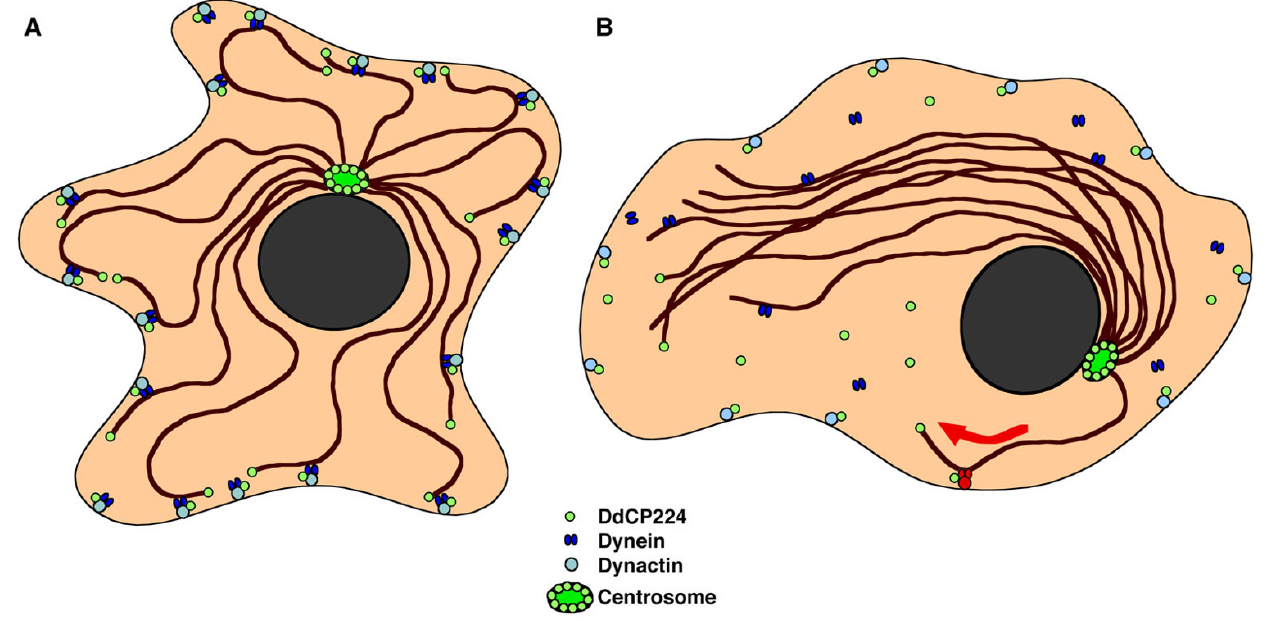
Figure 7 Model for the collapse of radial interphase microtubule arrays by disruption of cortical dynein/dynactin func- tion. (A) Cortical dynein/dynactin in cooperation with DdCP224 provides the pulling force for maintenance of radial microtu- bule arrays. (B) Collapse of the radial microtubule array and altered centrosome positioning due to disruption of most cortical dynein/dynactin complexes and asymmetric pulling forces provided by only a few remaining functional cortical dynein/dynactin complexes (shown in red). This pathway may also involve further proteins which are not depicted in this